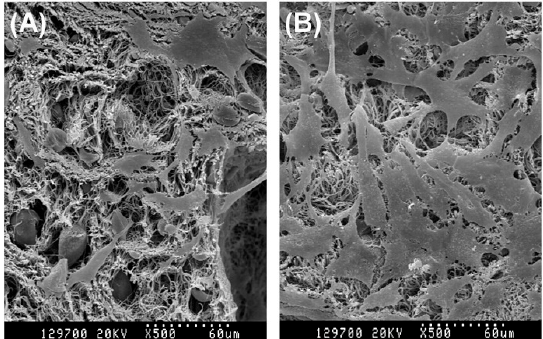
Figure 17. SEM micrographs of nHAC-kn cultured for seven days onto untreated ( A ) and Ar plasma-modified ( B ) 3D porous nanofibrous silk fibroin scaffolds—reproduced with permission from [249].